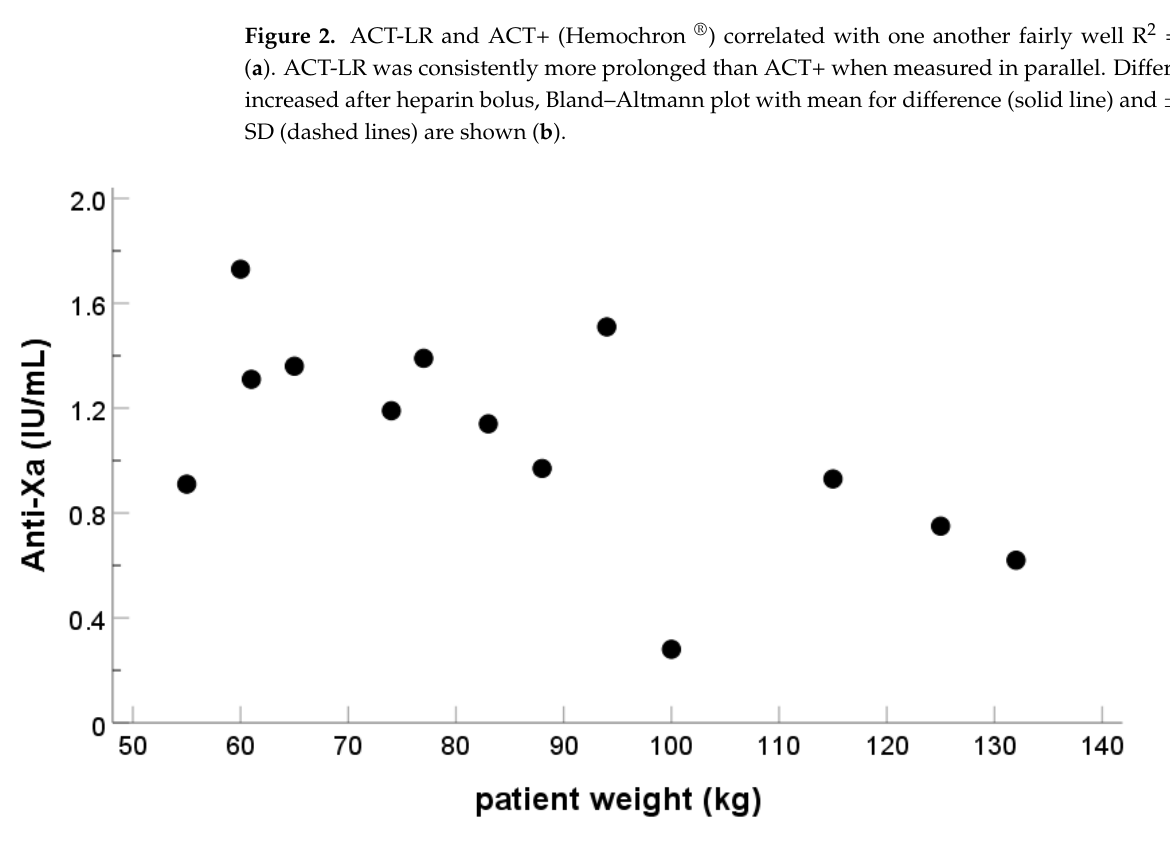
Figure 3. UFH level measured with chromogenic anti-FXa (IU/mL) after 5000 IU bolus and weight of the patient (kg), UFH level after 5000 IU UFH bolus. The correlation between patient weight and anti-Xa measurement was poor (A), R 2 = 0.38. The correlation with ACT-LR measurement was even poorer R 2 = 0.22.